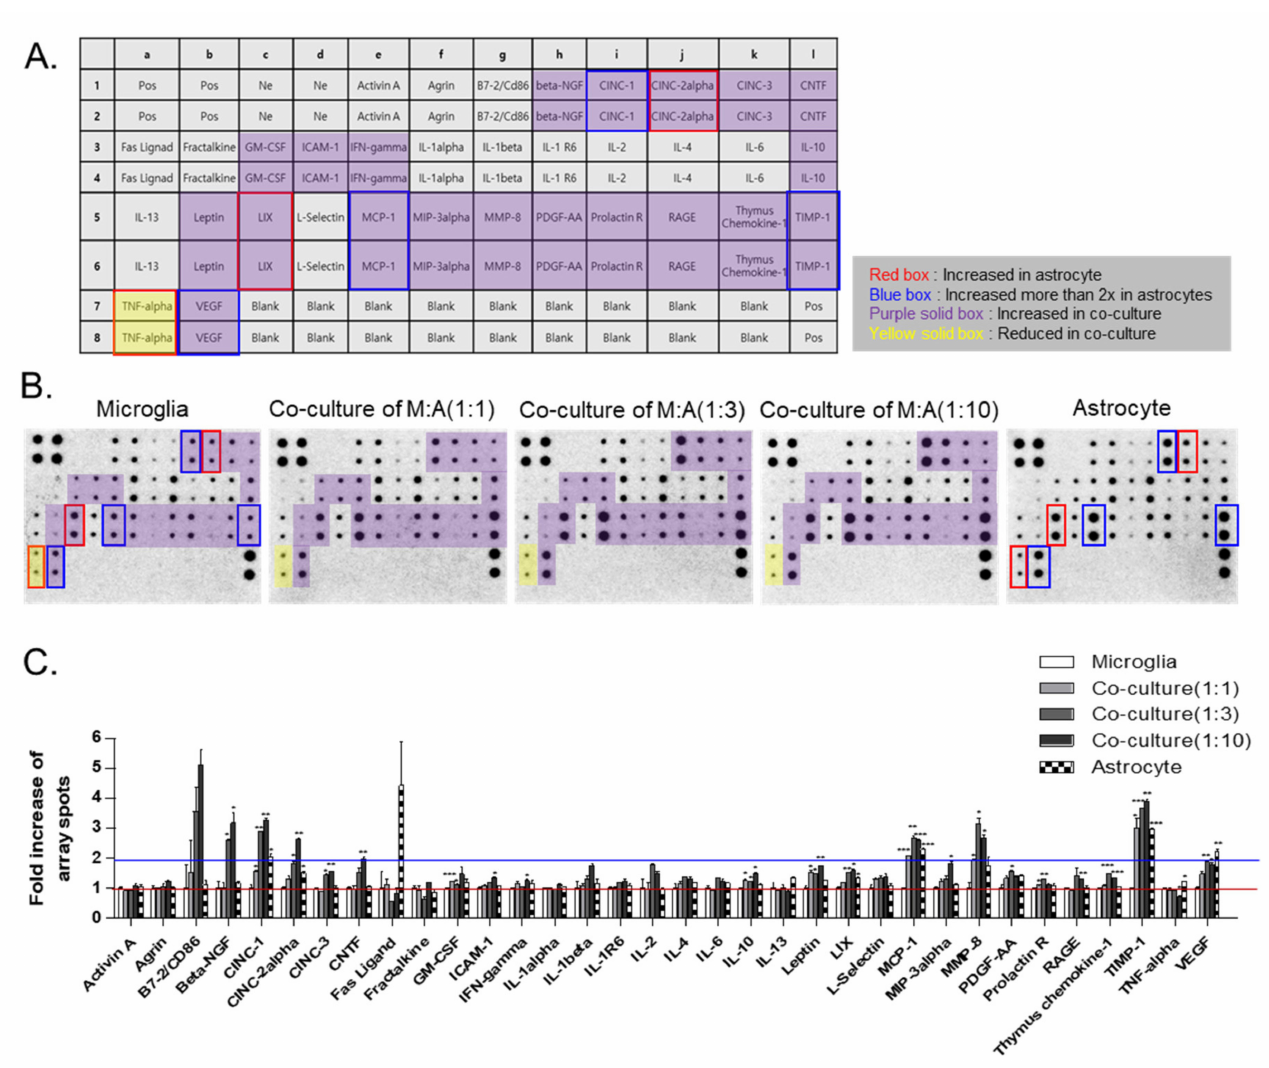
Figure 4. The secretome analysis of single or co-culture of microglia and astrocytes with rat cytokine array: ( A ) cytokine array map. The array can detect 34 soluble mediators. Pos: positive control; Ne: negative control. ( B ) The cytokine arrays were performed with conditioned medium of microglia, astrocyte single culture, or microglia–astrocyte co-culture in various ratios. ( C ) The quantitative data of the fold increase in array spots between microglia, astrocyte single culture, and microglia–astrocyte co-culture. Red line: 1x baseline of array spots; Blue line: 2x baseline of array spots. * p < 0.05, ** p < 0.01, and *** p <